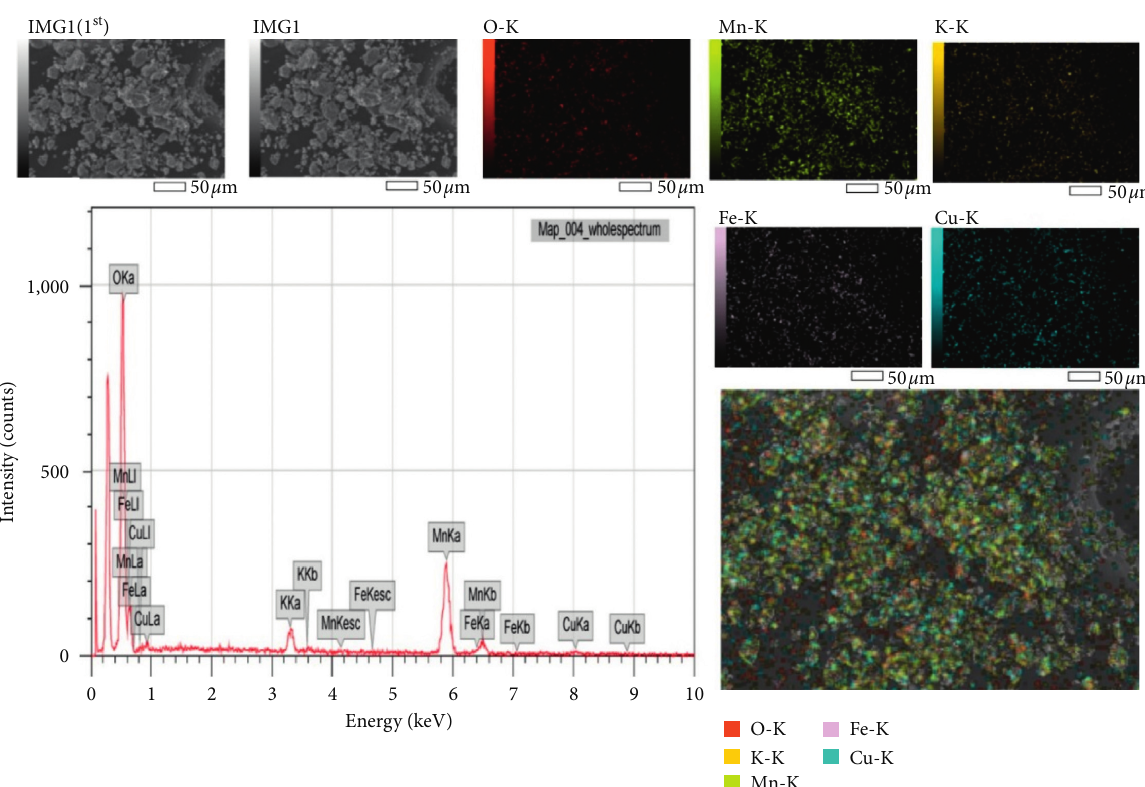
x /OMS-2 catalyst.